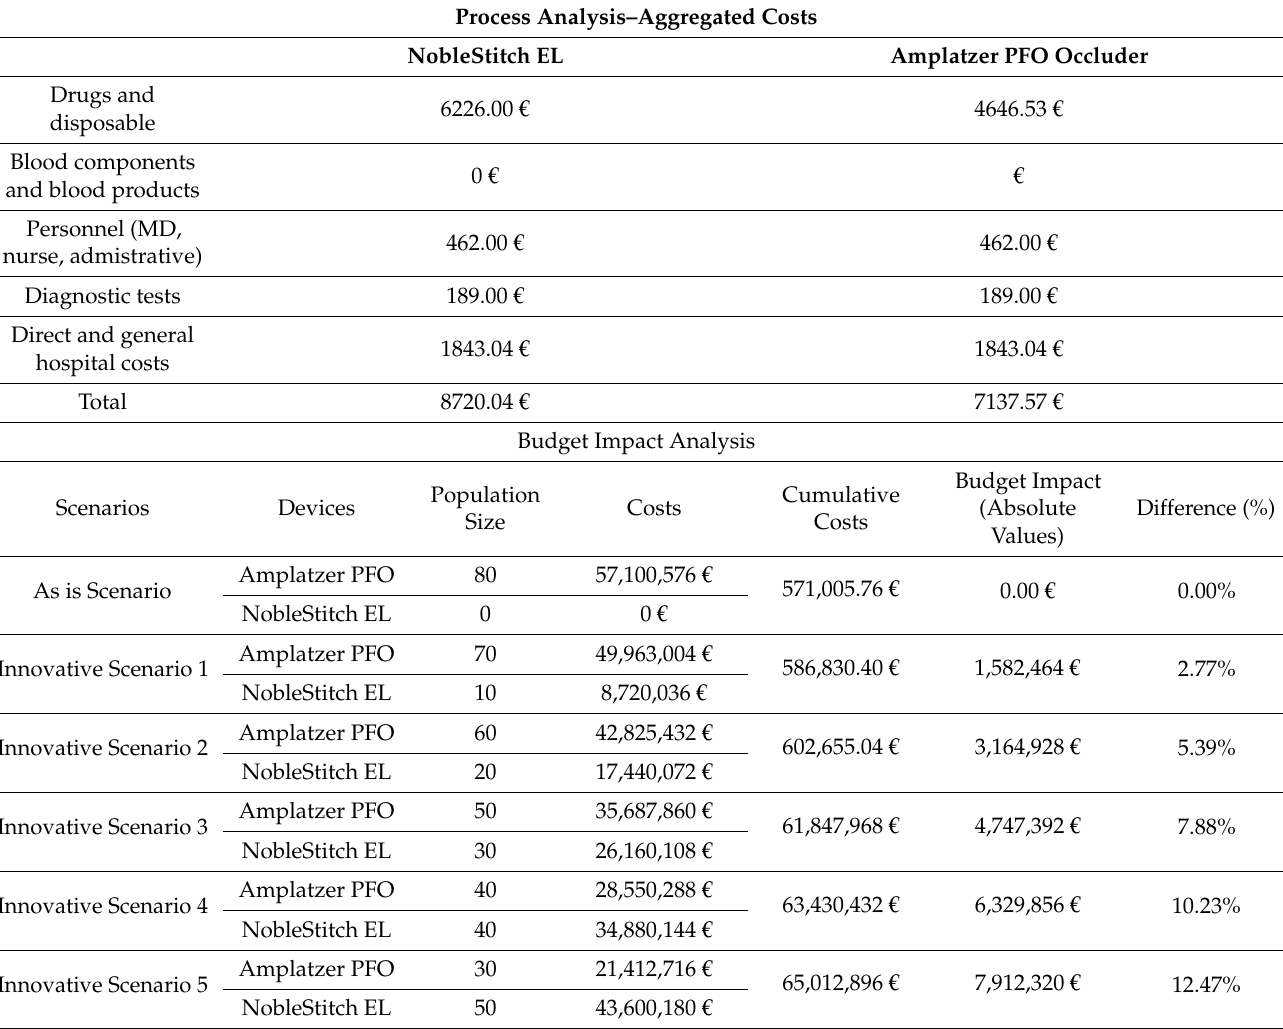
Table 3. Economic Analysis–Annual